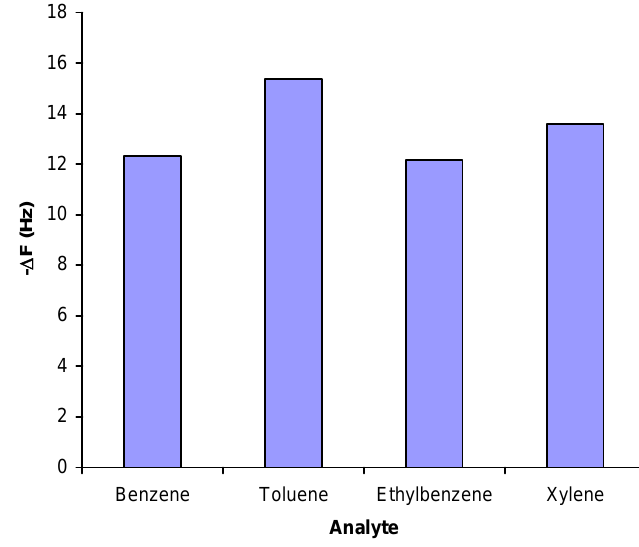
Figure 7. Sensivity of polystyrene-coated QCN towards BTEX